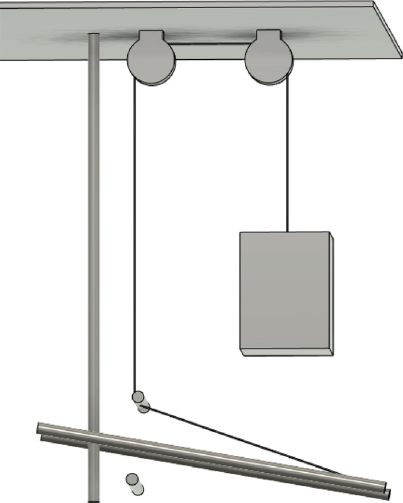
Figure 11. The path of the pulley string in the upward movement. From the tip of the lower arm, the string is passed through the short compression material inside the joint to apply the force of the weight. The weight is not in the position shown in this figure. The weight is in a position below the lower arm by extending the string so that it does not contact the arm.